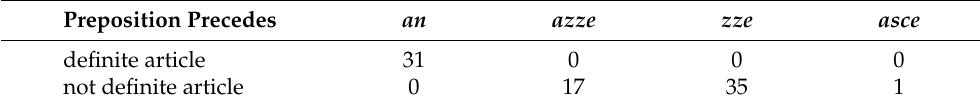
Table 1. Counts of prepositions with/without immediately following definite